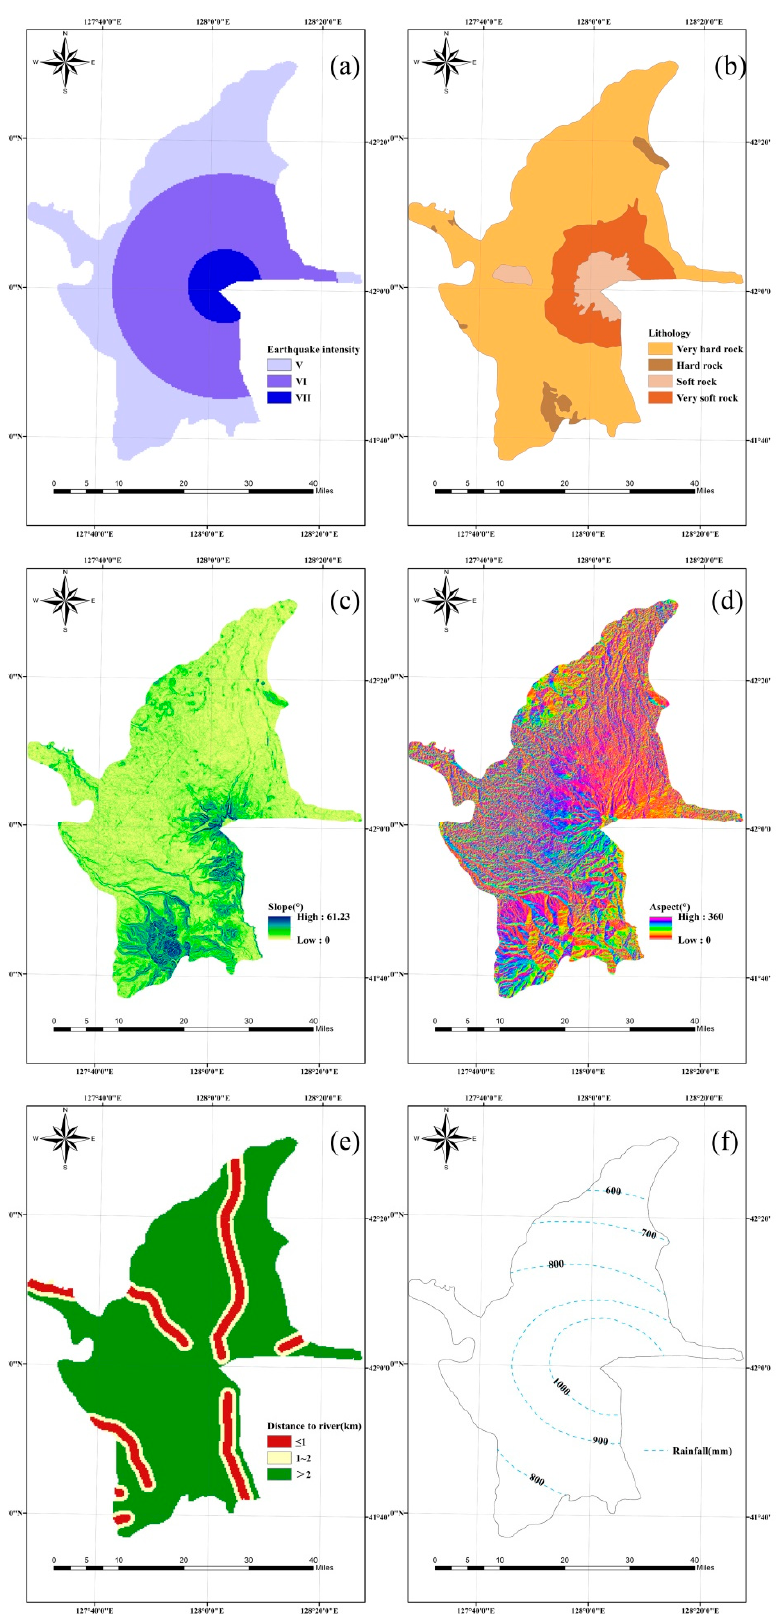
Figure 4. Condition parameters: ( a ) Earthquake intensity, ( b ) lithology, ( c ) slope, ( d ) aspect, ( e ) distance to the river, and ( f ) precipitation.